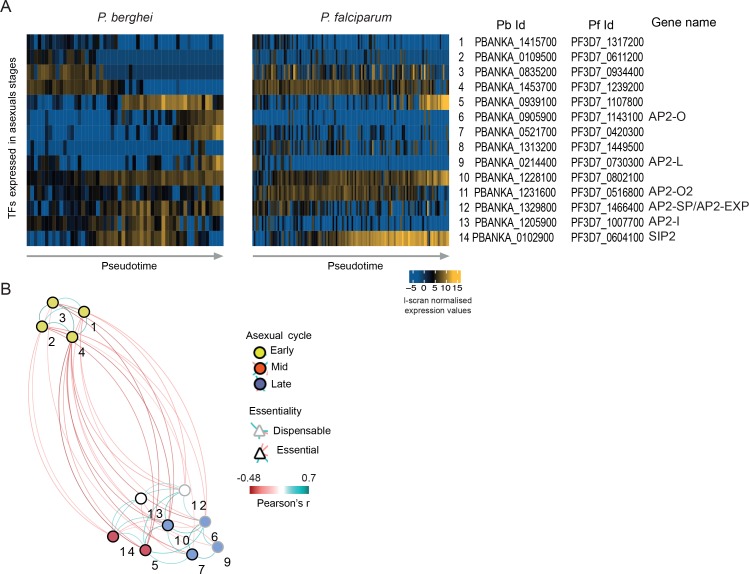
Analysis of the co-expression pattern of the ApiAP2 family of transcription factors (TFs) in asexual parasites.(A) Expression of Plasmodium ApiAP2 genes in asexual parasites. Orthologous genes are presented on the same rows. (B) A co-expression network for P. berghei was built using significant positive and negative correlations (p<0.05 by Pearson’s correlation) between TFs and weighted according to their correlation coefficient. Numbers on the network refers to the TFs as presented in A.